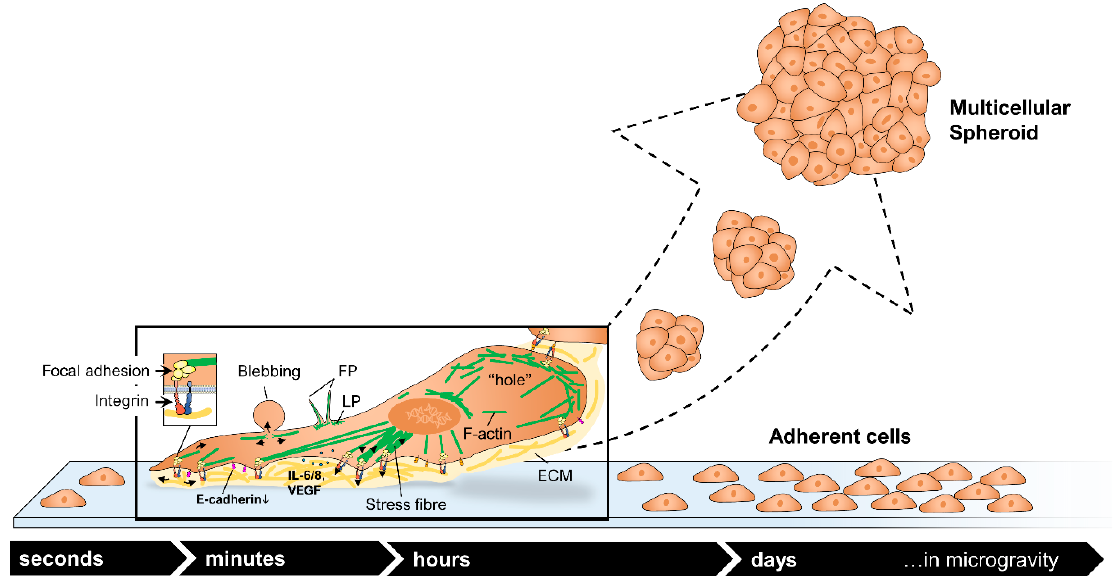
Figure 11. Alterations of adherently growing cancer cells after exposure to microgravity (modified from [65]). The figure in the box shows changes at the microscopic level. F-actin is displayed as green lines, the ECM in yellow. FP: filopodia, LP: lamellipodia.